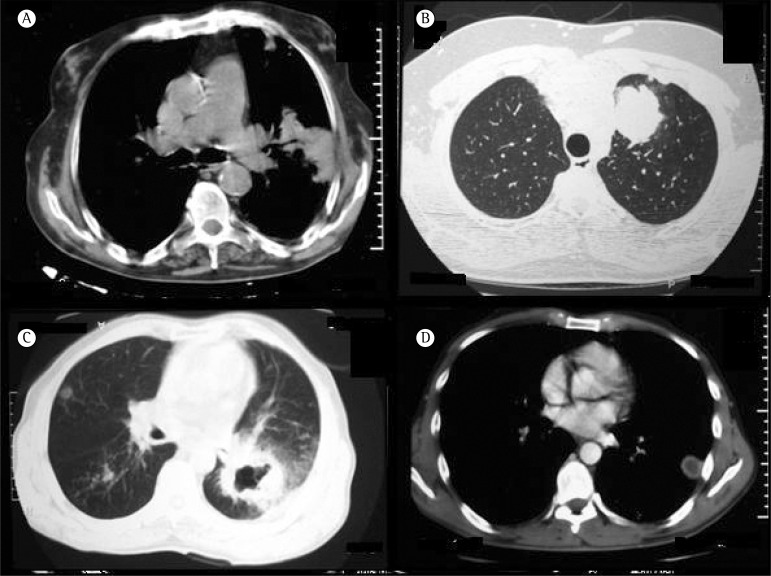
Cortes de TC helicoidal mostrando contornos de massa pulmonar irregular
(em A; paciente masculino, 77 anos) e dos tipos bocelado (em B; paciente
masculino, 30 anos), espiculado (em C; paciente masculino, 64 anos) e
regular (em D; paciente masculino, 36 anos).